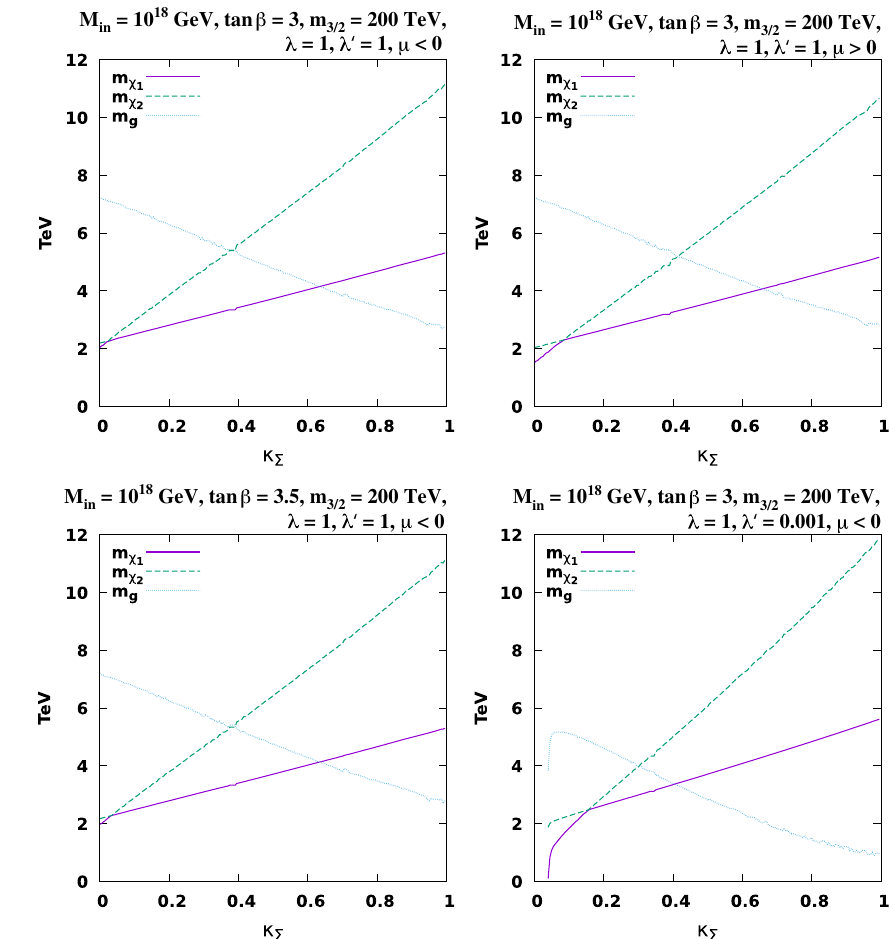
Fig. 8 Gaugino masses as functions of κ (cid:6) for κ = κ ¯ = 0, H H M in = 10 18 GeV, m 3 / 2 = 200 TeV and λ = 1. In a μ < 0, tan β = 3 and λ (cid:7) = 1; b μ > 0, tan β = 3 and λ (cid:7) = 1; c μ < 0, tan β = 3 . 5 and λ (cid:7) = 1; d μ < 0, tan β = 3 and λ (cid:7) = 0 .